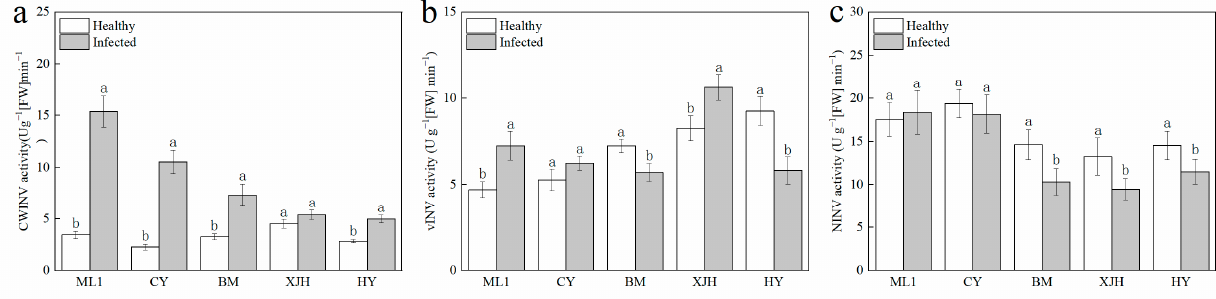
Figure 3. Activities of CWINV ( a ), vINV ( b ), NINV ( c ) invertase in the phloem of five kiwifruit cultivars canes after 30 days inoculation of Pseudomonas syringae pv. actinidiae (Psa). The data represent means from three biological replicates. Error bars = SD. Columns with different letters are significantly different at p < 0.05.